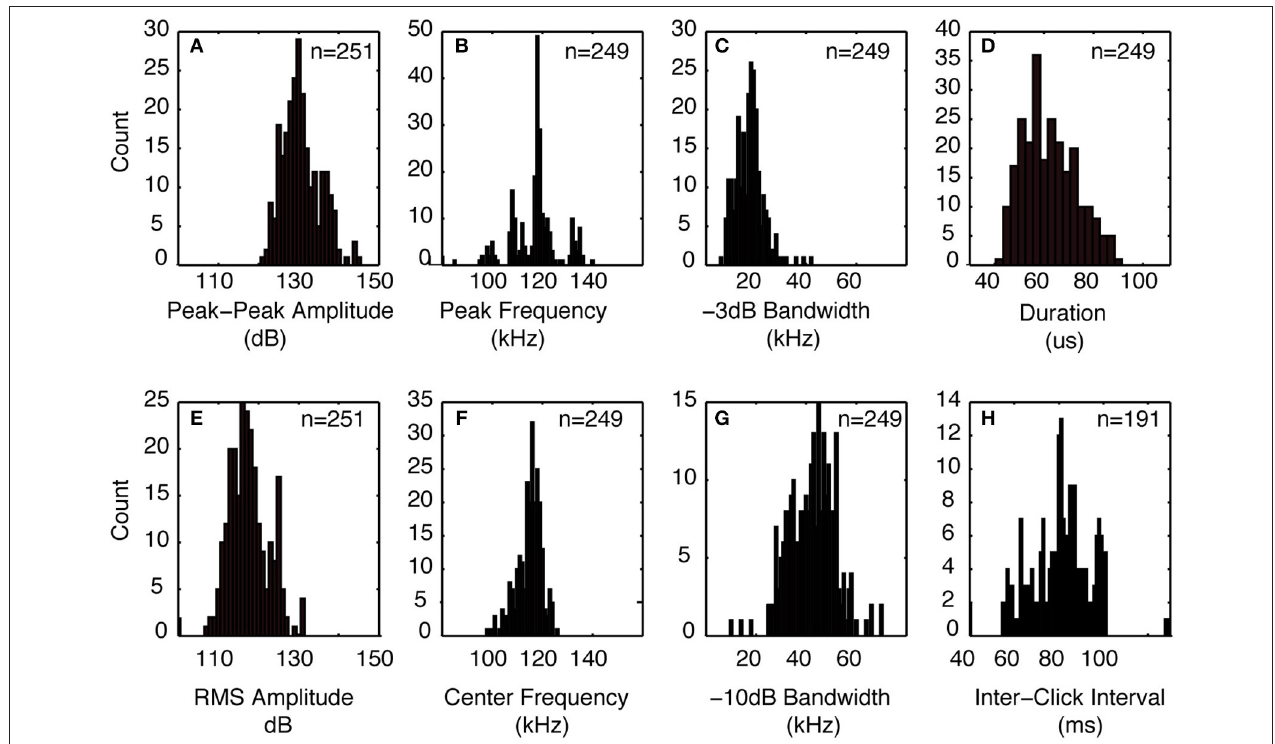
FIGURE 3 | Click characteristics from Kogia spp. encounters recorded with 160kHz bandwidth at the MC site in the GOM. (A) peak-peak amplitude, (B) peak frequency, (C) − 3 dB bandwidth, (D) click duration, (E) RMS amplitude, (F) click center frequency, (G) − 10 dB bandwidth, and (H) inter-click interval. Indicated numbers are for all recorded clicks collected during four encounters.